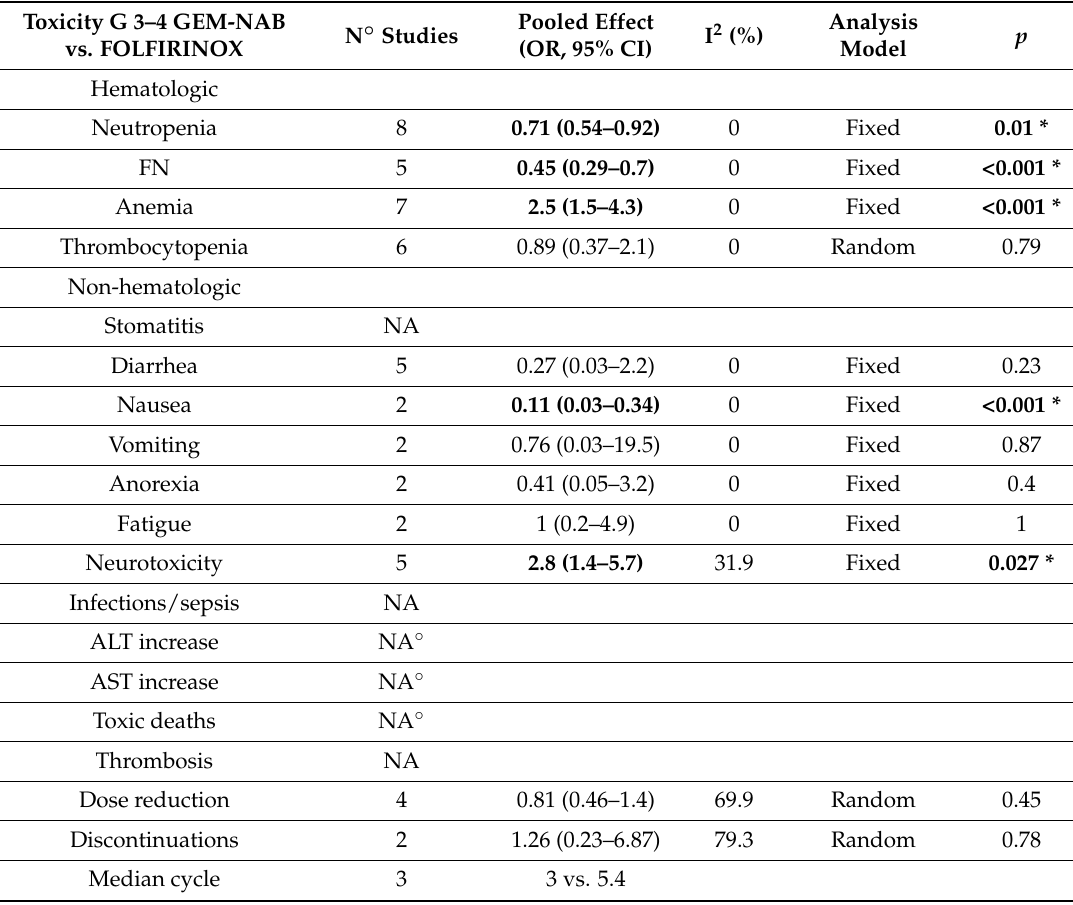
Table 2. Toxicity results for FOLFIRINOX compared to gemcitabine plus nab-paclitaxel